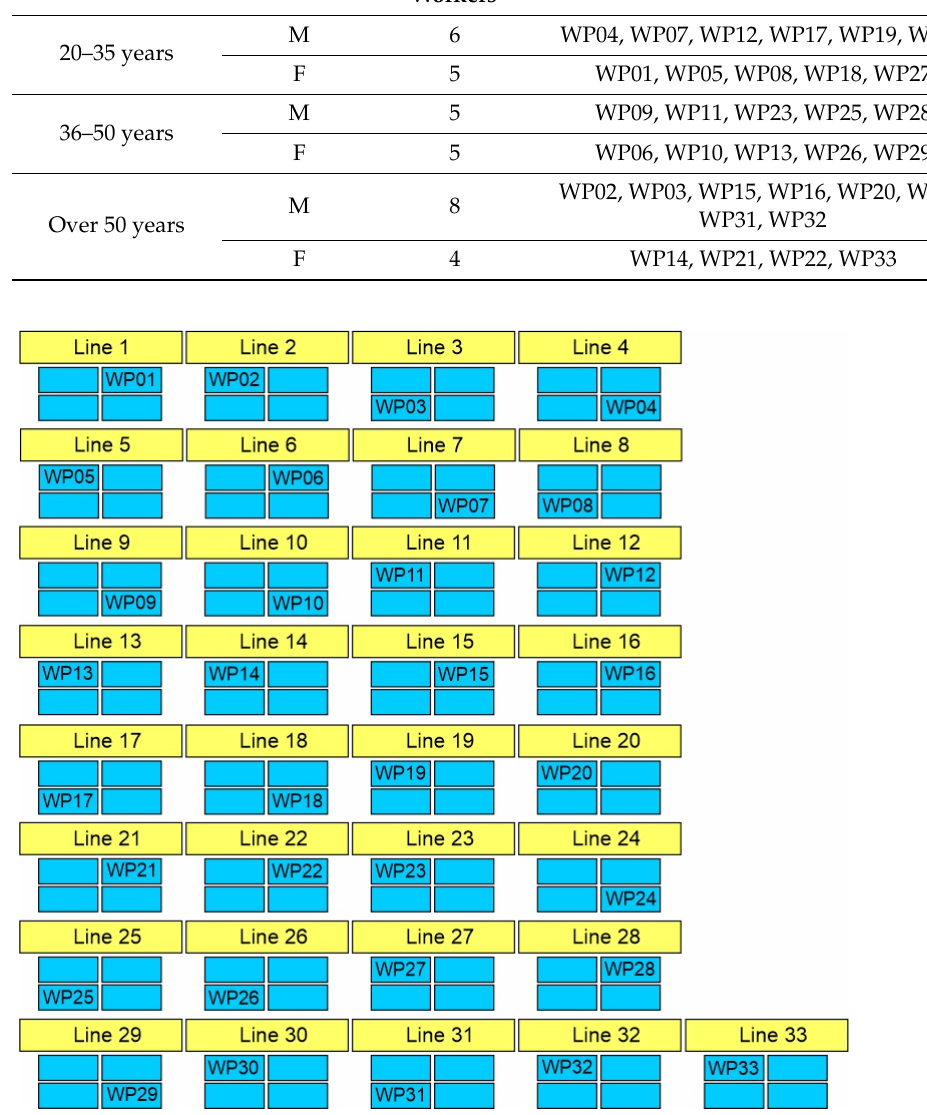
Figure 3. Scheme of the workplaces’ location on the production